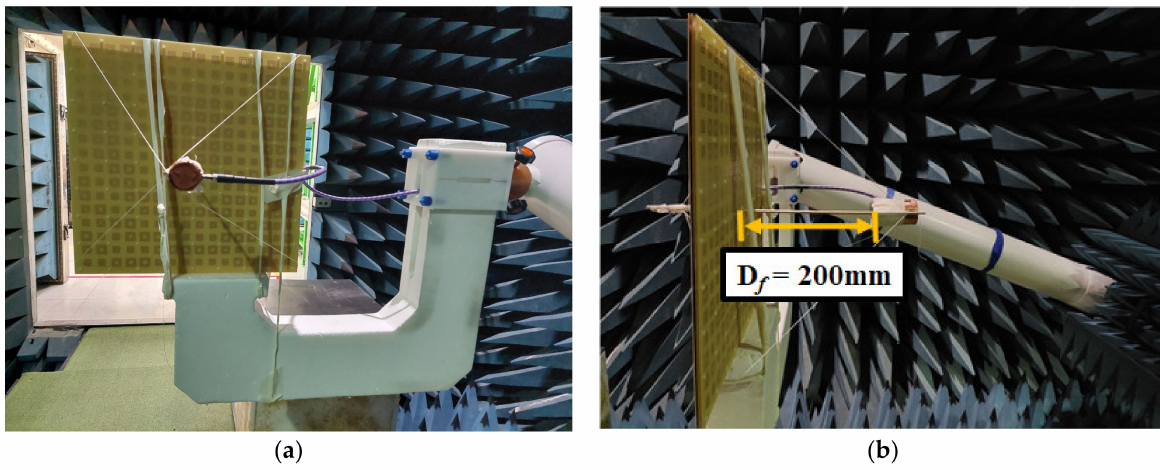
Figure 5. Fabricated 16 × 16 reflectarray in the anechoic chamber: ( a ) front and ( b ) side views. All antenna parameters were measured in an anechoic chamber. The designed antenna has a broad impedance bandwidth of 5.8–6.0 GHz (Figure 6a) and high antenna gain value of 6.8~7.8 dBi (Figure 6b). The measured cross-pol suppression level was higher than 20 dB at the operation frequency band. All the simulation results show good agreement with the measurement